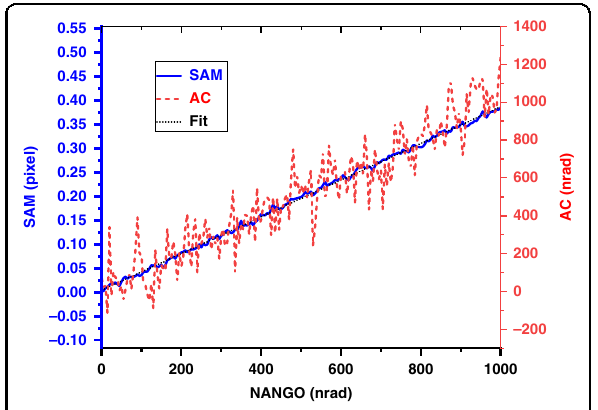
Fig. 10 Calculated and measured system calibration coef fi cient. The calibration coef fi cient κ and its reciprocal as the function of the distance between the mirror surface and the